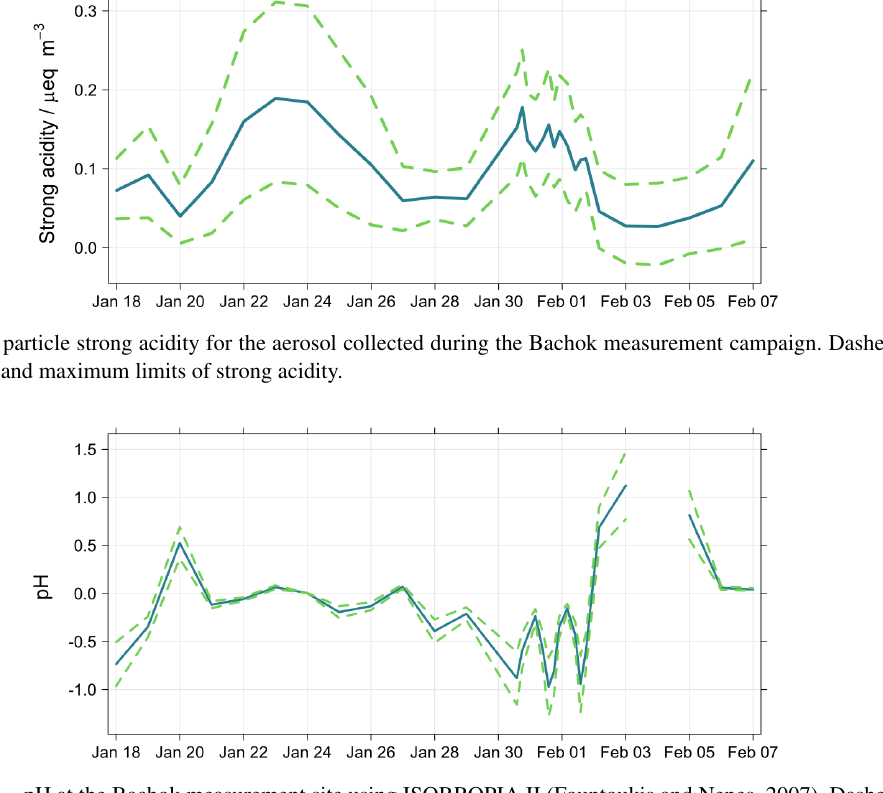
Figure 9. Predicted PM 2 . 5 pH at the Bachok measurement site using ISORROPIA II (Fountoukis and Nenes, 2007). Dashed lines represent predictions of minimum and maximum limits of